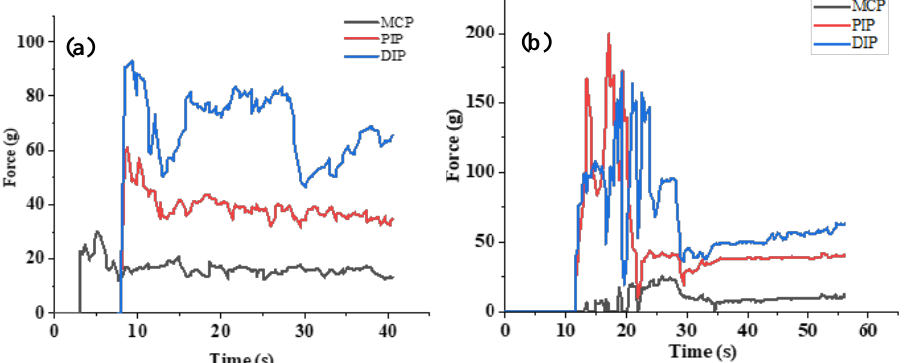
Figure 8. Pressure variation at the three joints of fingers. ( a ) Pressure changes on the three joints of the middle finger. ( b ) Pressure changes on the three joints of the little finger. Table 3. Pressure correlation coefficient of the three-finger